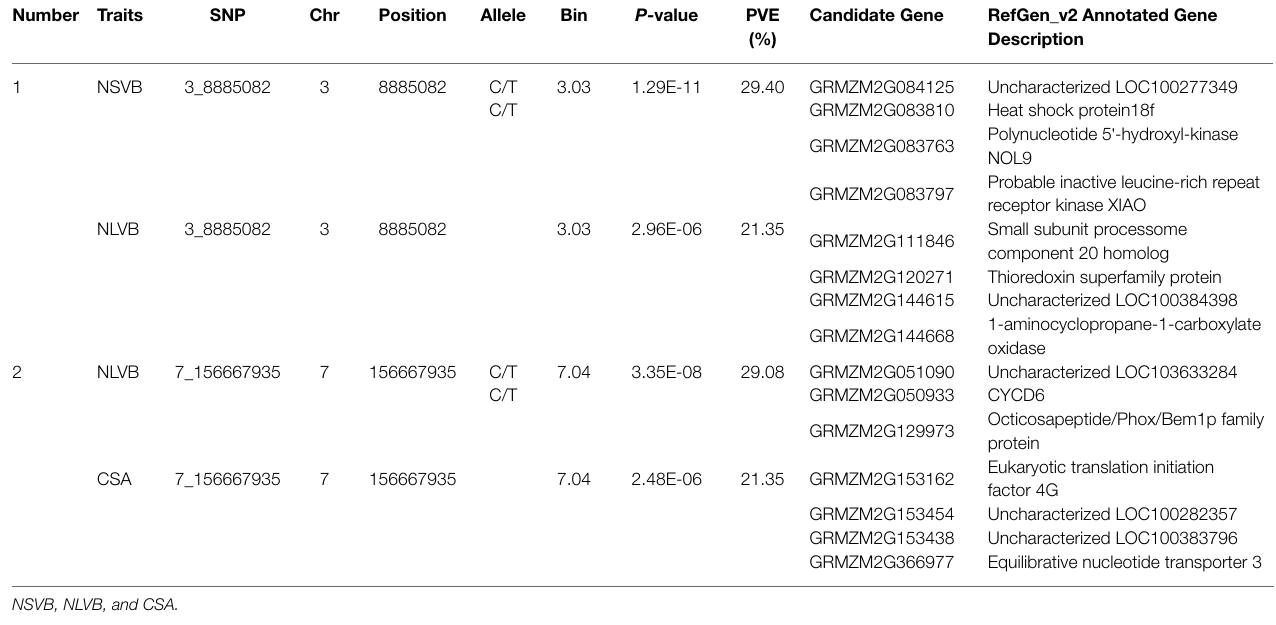
TABLE 4 | Co-loci of vascular bundle-related